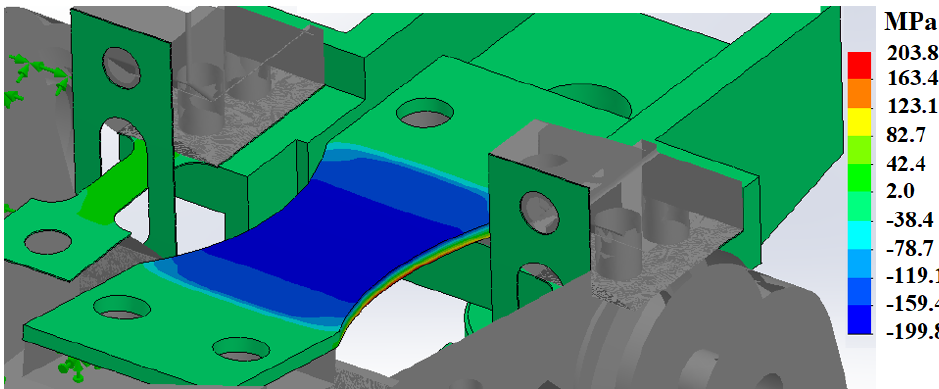
Figure 10. Stress gradient on the specimen under stress of 200 MPa.